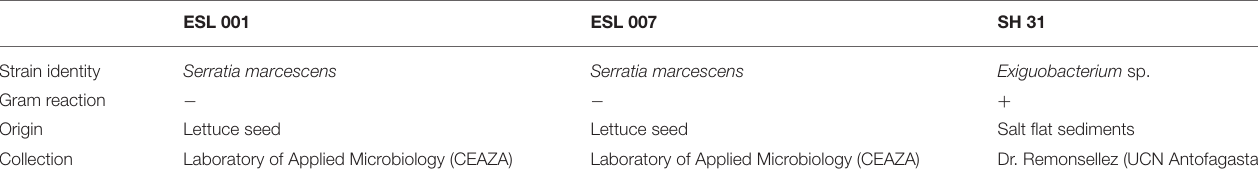
TABLE 1 | Identity and origin the three selected strains. ESL